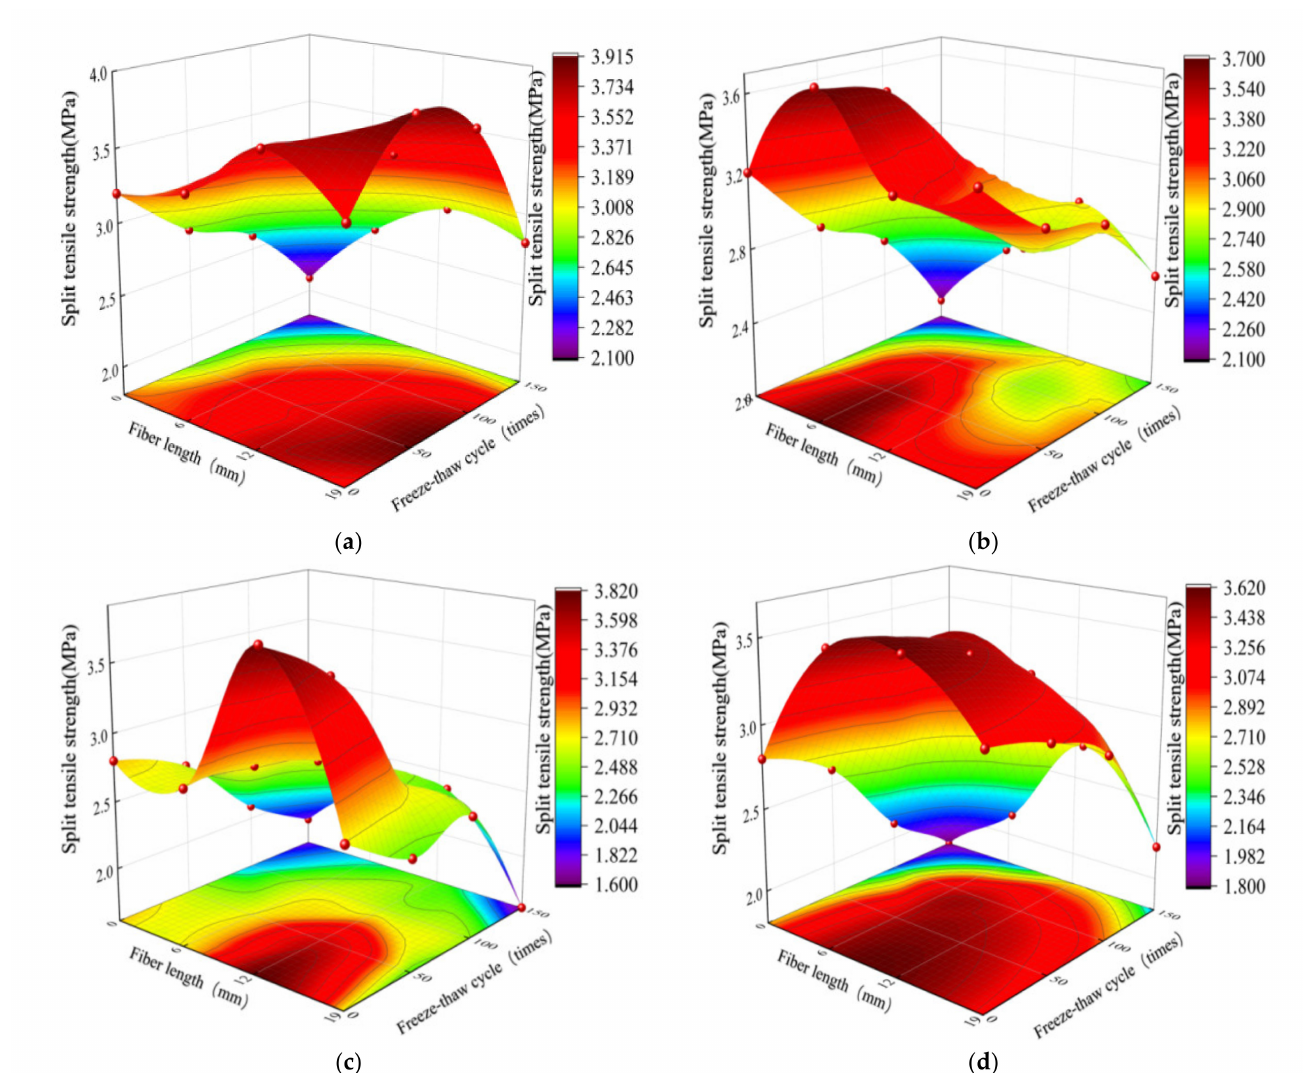
Figure 5. Split tensile strength at different freeze–thaw cycles: ( a ) PFMSC splitting tensile strength value when PPF volume is 1.0%, ( b ) PFMSC splitting tensile strength value when PPF volume is 1.2%, ( c ) PFNSC splitting tensile strength value when PPF volume is 1.0%, ( d ) PFNSC splitting tensile strength value when PPF volume is